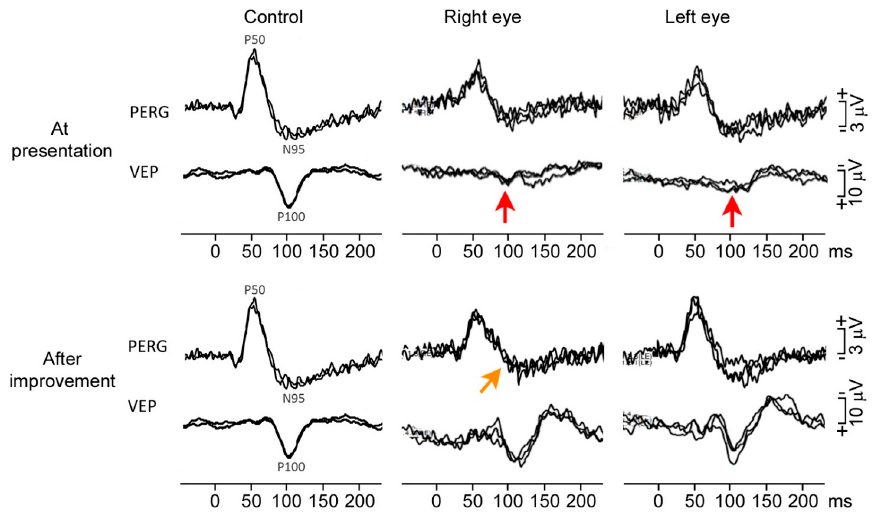
Figure 4. The P100 wave of the visual evoked potentials was diminished before treatment (red arrows) and normalized after treatment. A slightly reduced PERG N95 wave in the right eye after five months (orange arrow), showing slight retinal ganglion cell damage in the right eye and normal findings in the left eye.